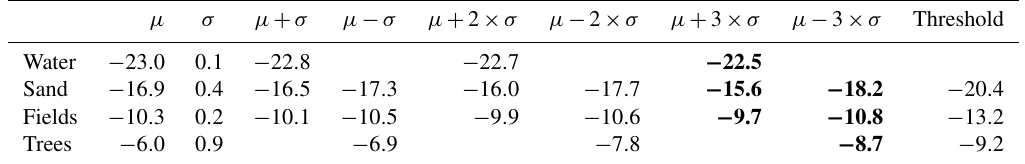
Table B1. Determination of thresholds for a sampling duration of 6 months and a 7 × 7 boxcar filter. Values in bold are those that have been used to calculate the threshold indicated in the last column. All values are in decibels (dB). µ – mean. σ – standard deviation. µ